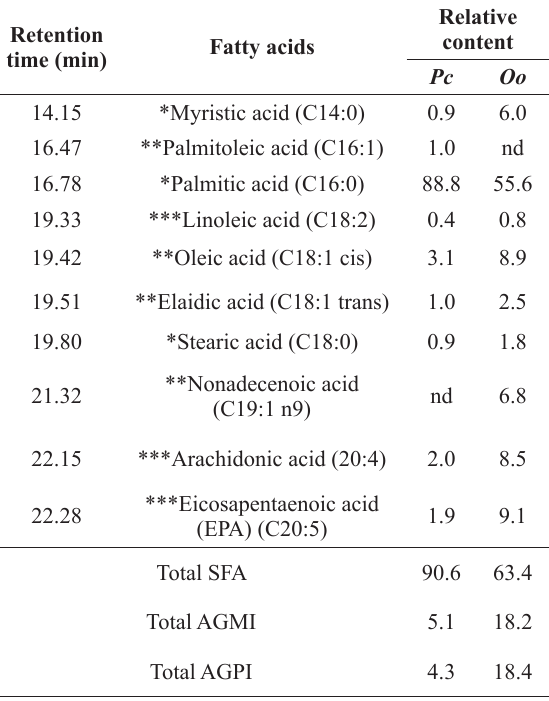
Chemical composition of fatty acids of the hexane extract from marine red algae Pterocladiella capillacea ( Pc ) and Osmundaria obtusiloba ( Oo ).